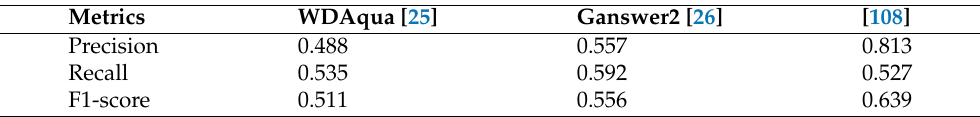
Table 6. Performance evaluation on the QALD-7